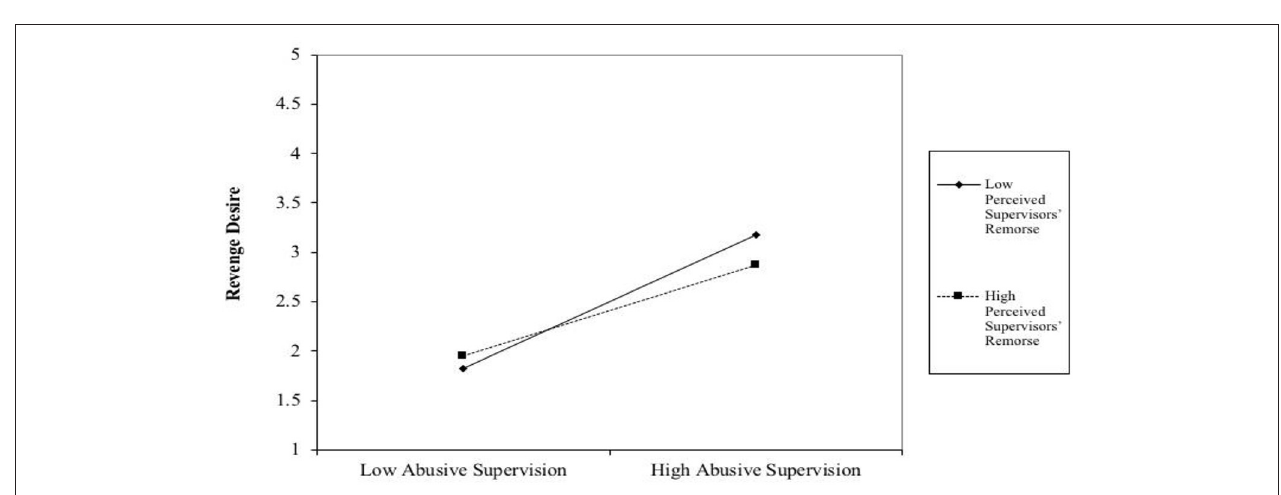
FIGURE 2 | Results of the moderated mediation model.